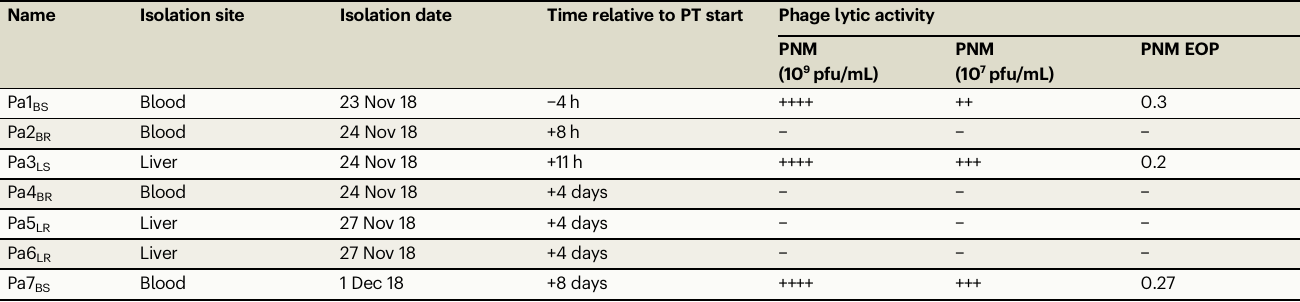
Table 1 | Phage susceptibility of seven Pseudomonas aeruginosa isolates retrieved before (Pa1BS) and during (Pa2BR – Pa7BS) phage therapy